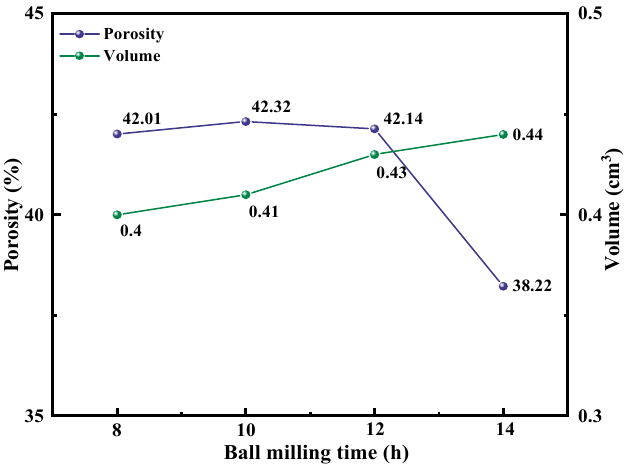
Figure 5. Changes of porosity and volume of mixed oxides after sintering at 800 °C for 4 h. The AC impedance of the sintered cathode body after different ball-milling times was tested. The curve fitting is shown in Figure 6. In the equivalent circuit, Rs is the aqueous solution resistance, Ω ; Rct is the cathode sheet resistance, Ω ; Wt is the diffusion impedance, and Ω ; CPE1 is a fitting capacitive element. According to Table 1, the impedance value gradually decreases with the increase in ball-milling time. When the ball-milling time is extended to 12 h, the impedance value changes obviously. This is mainly due to the existence of more dislocation defects in the particles caused by the long-time ball mill- ing, which reduces the transmission resistance of electrons and reduces the impedance value [11]. Table 1. Impedance values of mixed oxides after sintering. Z' / Ω Figure 6. AC impedance spectrum of mixed oxide after sintering.